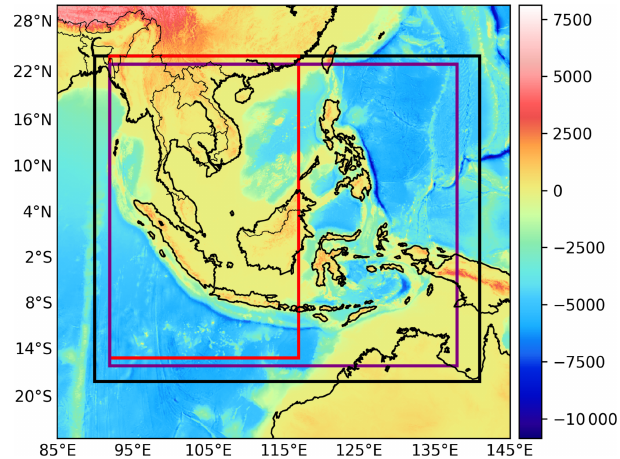
Figure 1. Bathymetry and orography (in metres) of the Maritime Continent from GEBCO 2014 data: MC coupled model domain (black box), western Maritime Continent domain in Thompson et al. (2018) (red box), and domain used for ocean forecast evaluation in present study (purple